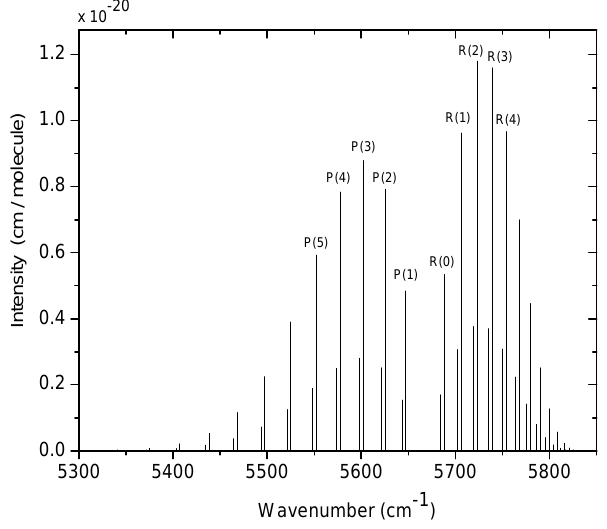
Fig. 1. Linestrengths of rotational lines of the 2-0 vibrational absorption band of H 35 Cl and H 37 Cl from HITRAN. The CRDS sensor uses the R(3) line of H 35 Cl at 5739.26 cm − 1 .